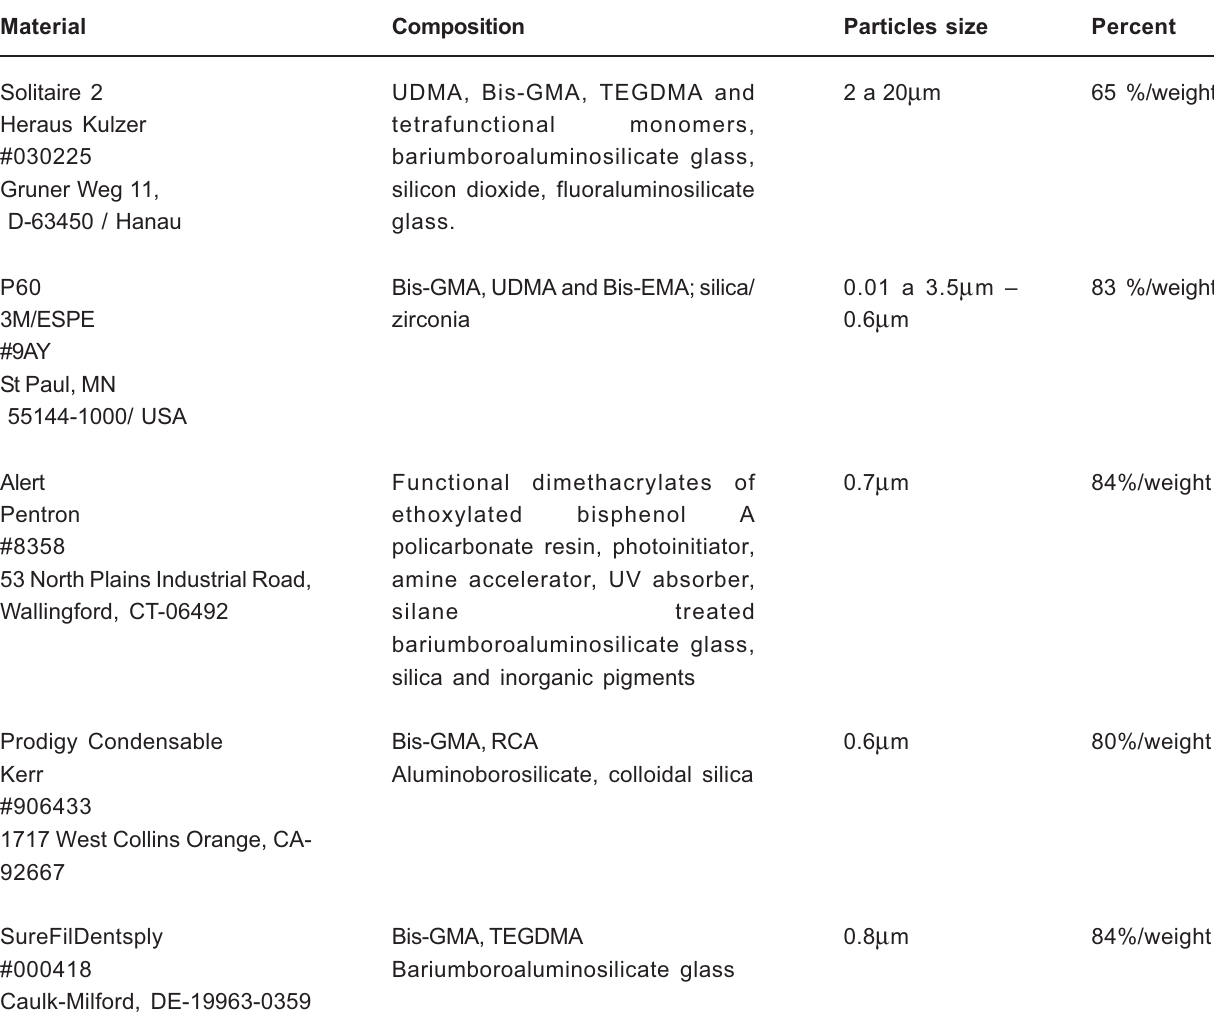
TABLE 1- Description of the composite